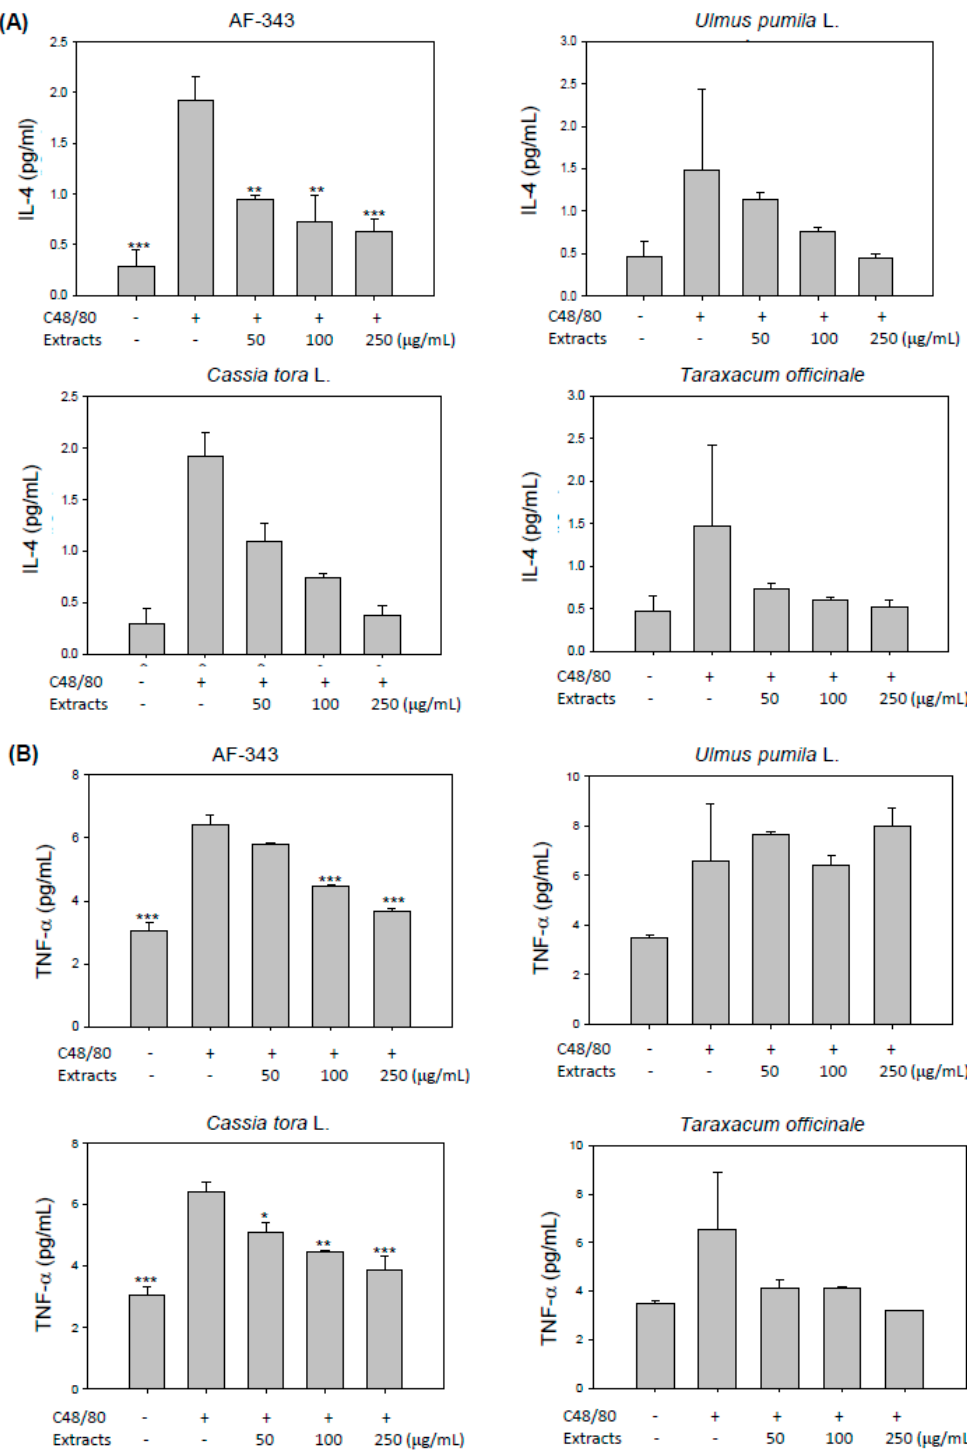
Figure 3. Ameliorative e ff ects of AF-343 and extracts of Ulmus pumila L., Cassia tora L., and Taraxacum o ffi cinale on compound 48 / 80-induced cytokine release in RBL-2H3 cells. ( A and B ) Supernatants were taken after 24 h of incubation for determination of cytokine concentrations using a V-PLEX Proinflammatory Panel 2 (Rat) Kit. The results are expressed as the means ± SD from three independent experiments. * p < 0.05, ** p < 0.01 and *** p < 0.001 vs. the compound 48 / 80 only group. C48 / 80, compound 48 / 80.